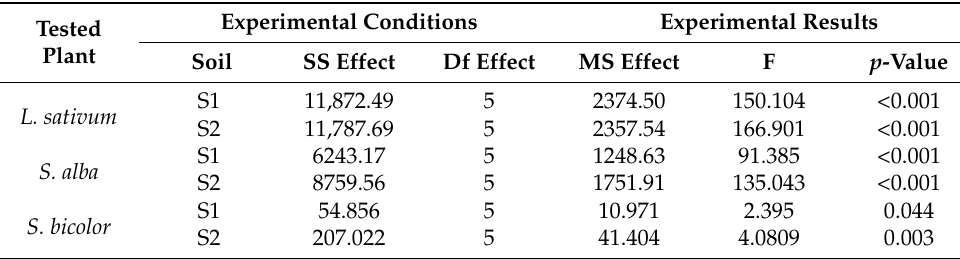
( b ) Figure 4. Data represent the average value ±the standard deviation ( n = 15) of the length of roots and shoots of the Lepidium sativum L. seeds tested on soil S1 ( a ) and S2 ( b ). Different letters indicate no significant differences Tukey’s test HSD ( p > 0.05); C—reference soil.